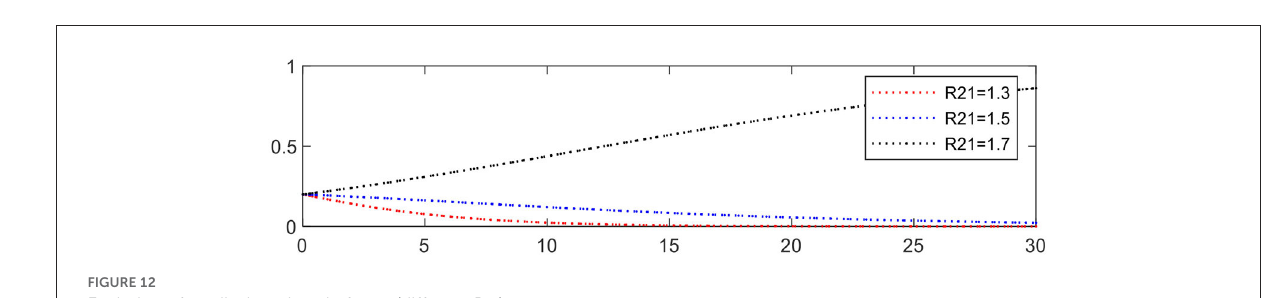
FIGURE12 Evolution of medical service platforms (different R 21 ).